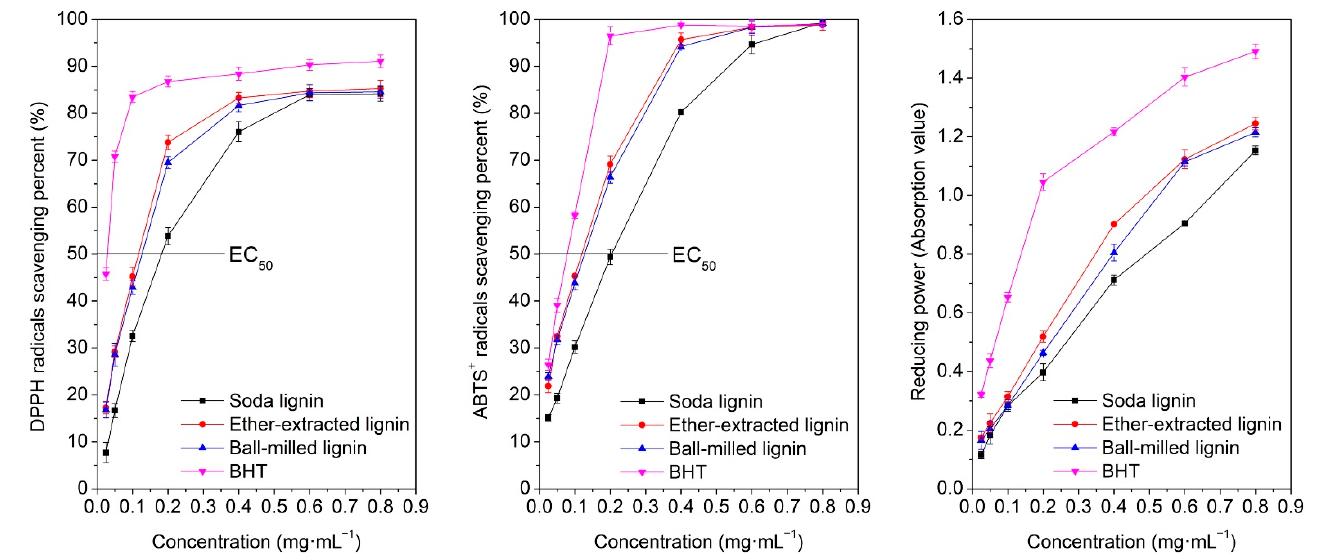
Figure 3. The antioxidant activities of different lignin and BHT samples.